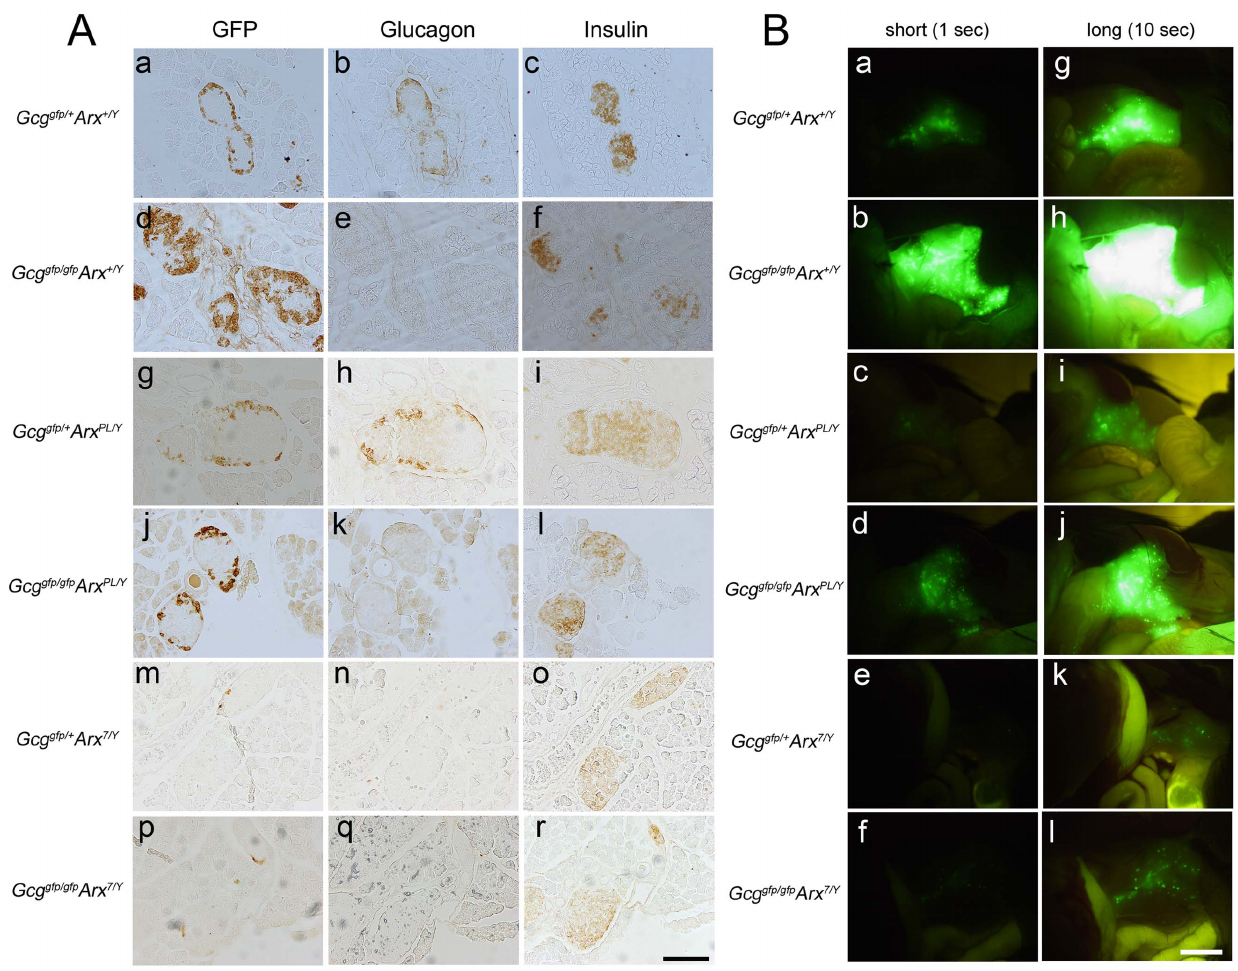
Figure 5. Immunohistochemical analyses and fluorescent imaging of the pancreas in Gcg/Arx double mutant mice. (A) Immunohistochemical analysis using anti-GFP (left column: a, d, g, j, m, and p), anti-glucagon (middle column: b, e, h, k, n and q) and anti-insulin (right column: c, f, I, l, o and r) antibodies. Pancreas from 2-week-old mice with the indicated genotypes was analyzed. a–c, Gcg gfp/ + Arx + /Y ; d–f, Gcg gfp/ gfp Arx + /Y ; g–i, Gcg gfp/ + Arx PL/Y ; j–l, Gcg gfp/gfp Arx PL/Y ; m–o, Gcg gfp/ + Arx 7/Y ; p–r, Gcg gfp/gfp Arx 7/Y . Scale bar, 100 m m. (B) GFP fluorescent images of the pancreas. The 6 images in the left column (a–f) and the 6 images in right (g–l) are identical except for the exposure time. a and g, Gcg gfp/ + Arx + /Y ; b and h, Gcg gfp/gfp Arx + /Y ; c and I, Gcg gfp/ + Arx PL/Y ; d and j, Gcg gfp/gfp Arx PL/Y ; e and k, Gcg gfp/ + Arx 7/Y ; and f and l, Gcg gfp/gfp Arx 7/Y . Scale bar, 1 mm.